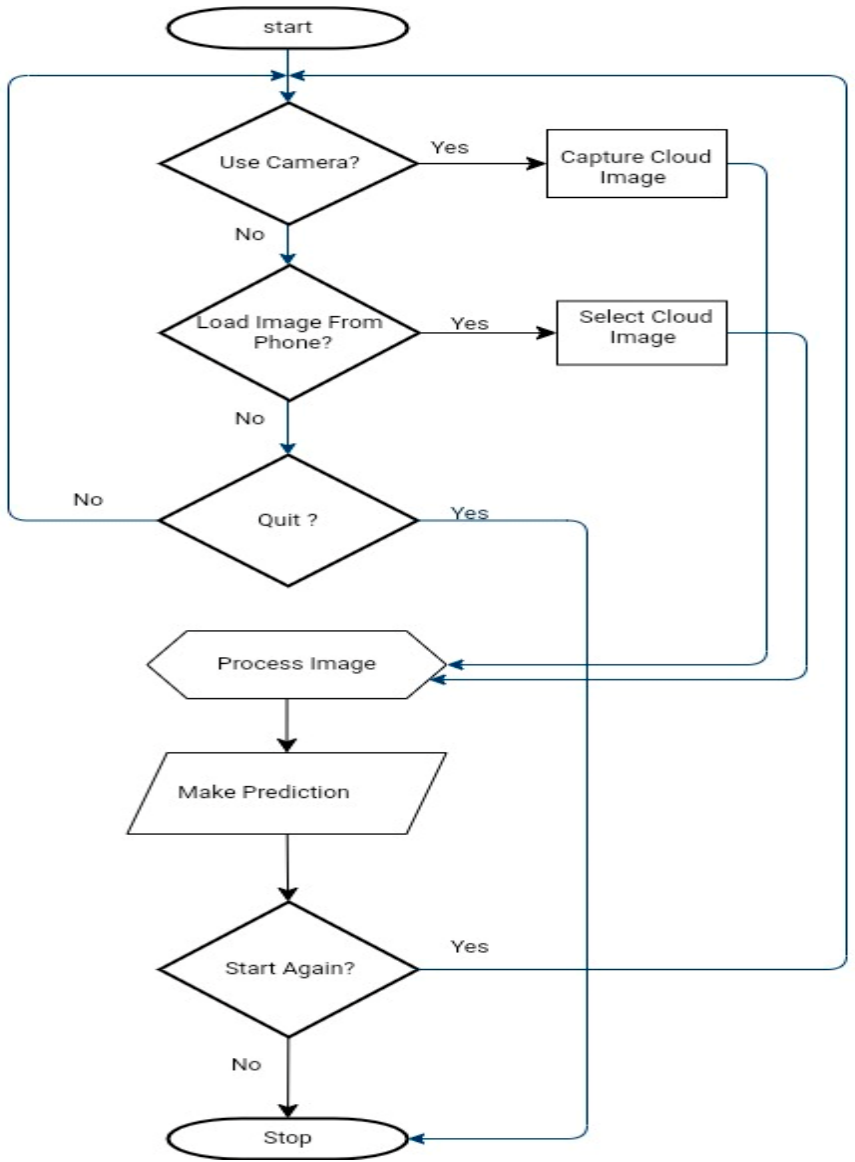
Figure 10. Flowchart of the smartphone implementation process of the Cloud-MobiNet model .